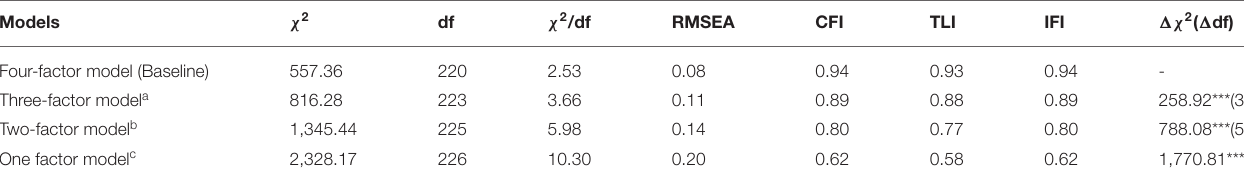
TABLE 2 | Confirmatory factor analyses of the research variables. Models χ 2 χ 2 /df RMSEA Four-factor model (Baseline)